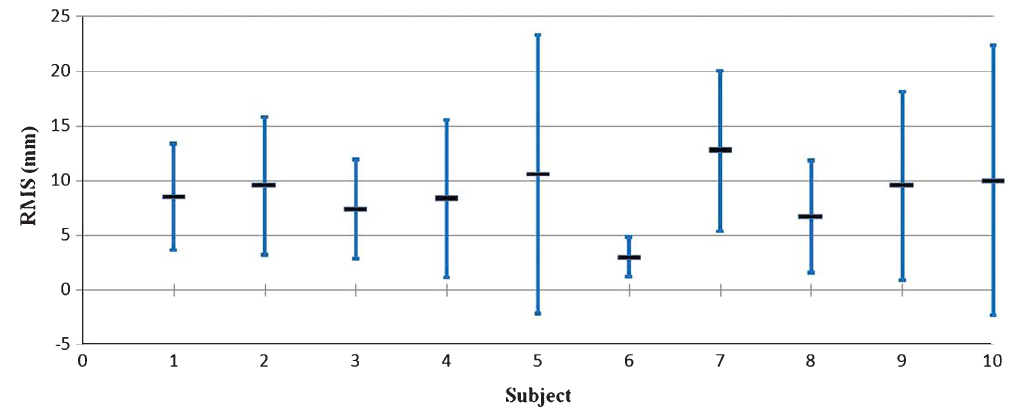
Fig. 11. RMS and standard deviation of the error between CoM estimation based on a SESC and CoM estimation based on anthropometric tables – Horizontal.